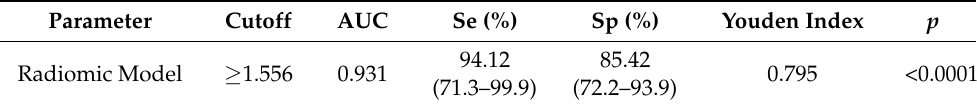
Table 6. The receiver operating characteristic analysis for the radiomic model predictive of the lymphoma- tous transformation of the parotid gland’s parenchyma in patients with primary Sjögren’s syndrome. Parameter Cutoff AUC Se (%) Sp (%) Youden Index Radiomic Model The 95% confidence interval values are shown in parentheses. AUC = area under curve; Se = sensitivity; Sp = specificity; p = statistical significance level. The areas under the ROC curve of the independent features associated with lymphoma development in pSS and the resulting radiomic model are depicted in Figure 4.